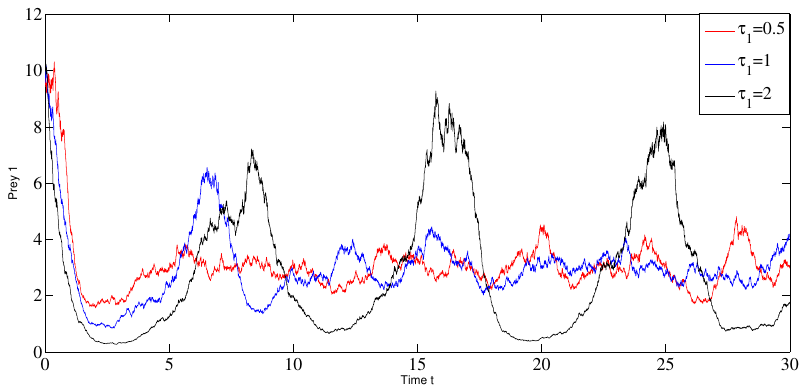
Figure 6. The behavior of the prey 1 population for different values of τ 1 .